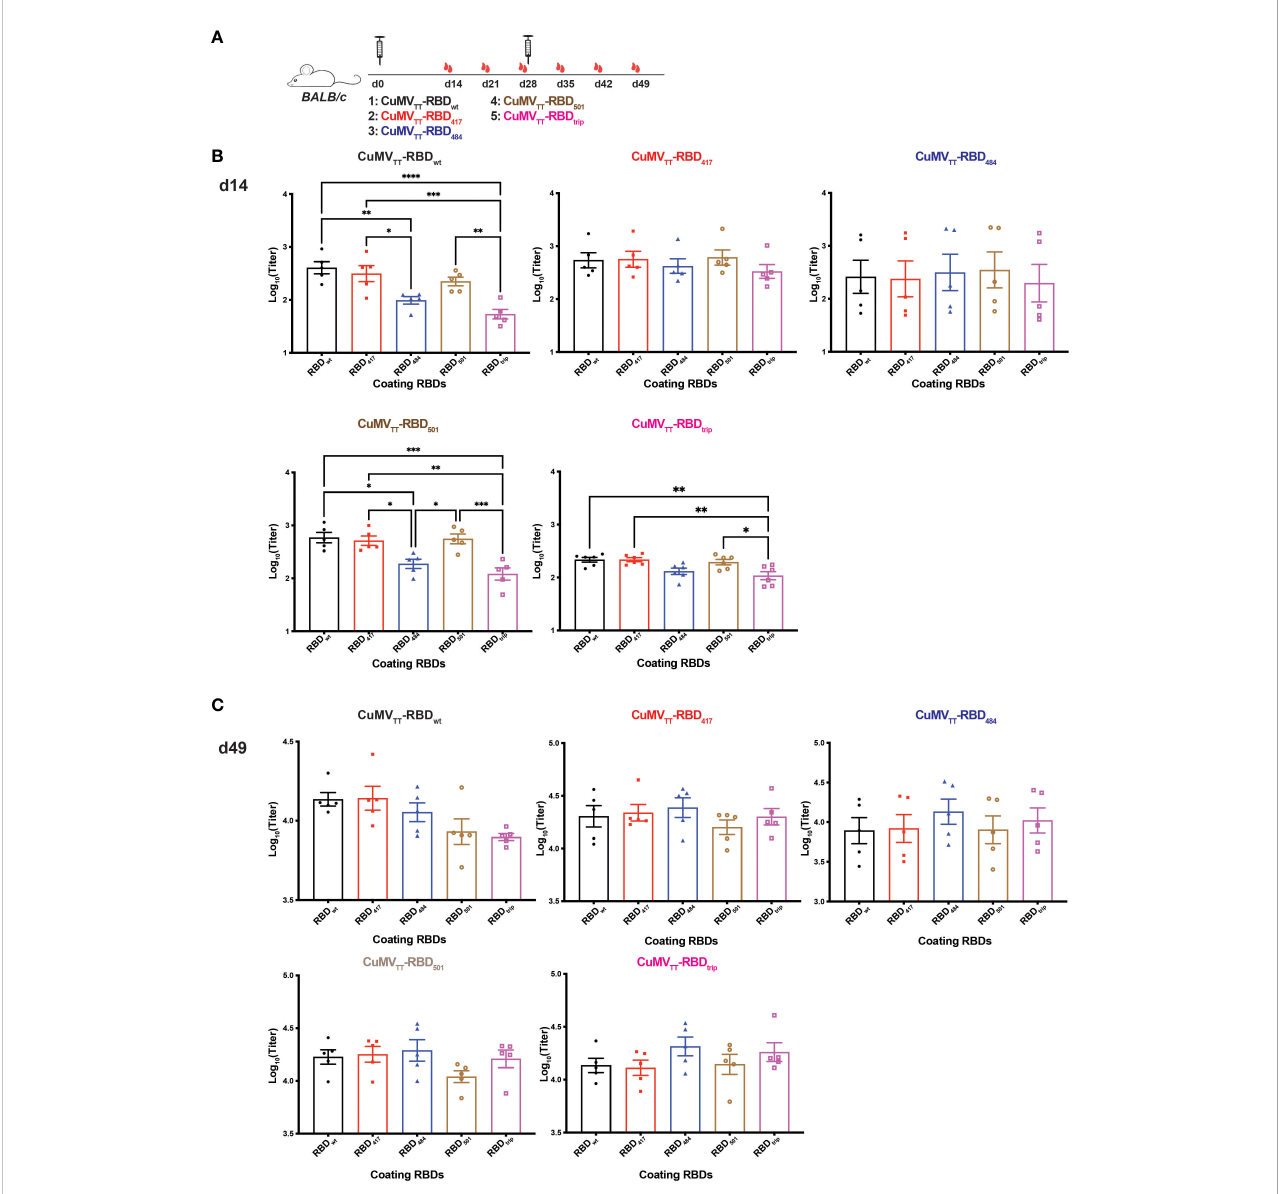
FIGURE 2 Immunogenicity of vaccines derived from VOC RBDs. (A) BALB/c mice were immunized on d0 and d28 with CuMV TT -RBD wt , CuMV TT -RBD 417 , CuMV TT - RBD 484 , CuMV TT -RBD 501 , and CuMV TT -RBD trip , and serum samples were collected on d14, 21, 28, 35, 42, 49. IgG antibody titers against RBD wt , RBD 417 , RBD 484 , RBD 501 , and RBD trip induced by all vaccines on d14 (B) and d49 (C) . One-way ANOVA analysis was performed in Prism 9 (n=5), a =0.5 and statistical signi fi cance was displayed as p ≤ 0.05 (*), p ≤ 0.001 (**), p ≤ 0.005 (***), p ≤ 0.001